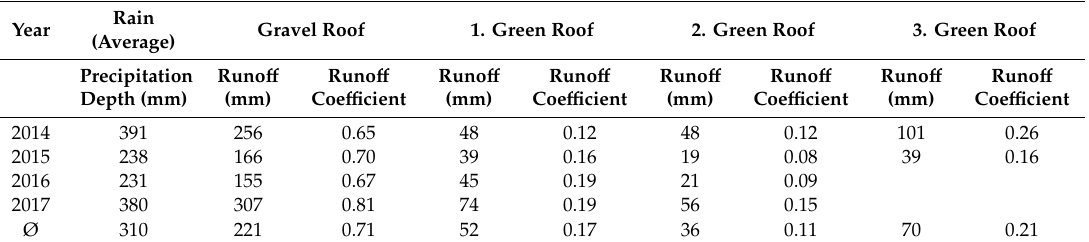
Table 4. Measurements of the runo ff coe ffi cients in the growing period (1 April to 31 September). Up to 90% of the precipitation was removed by